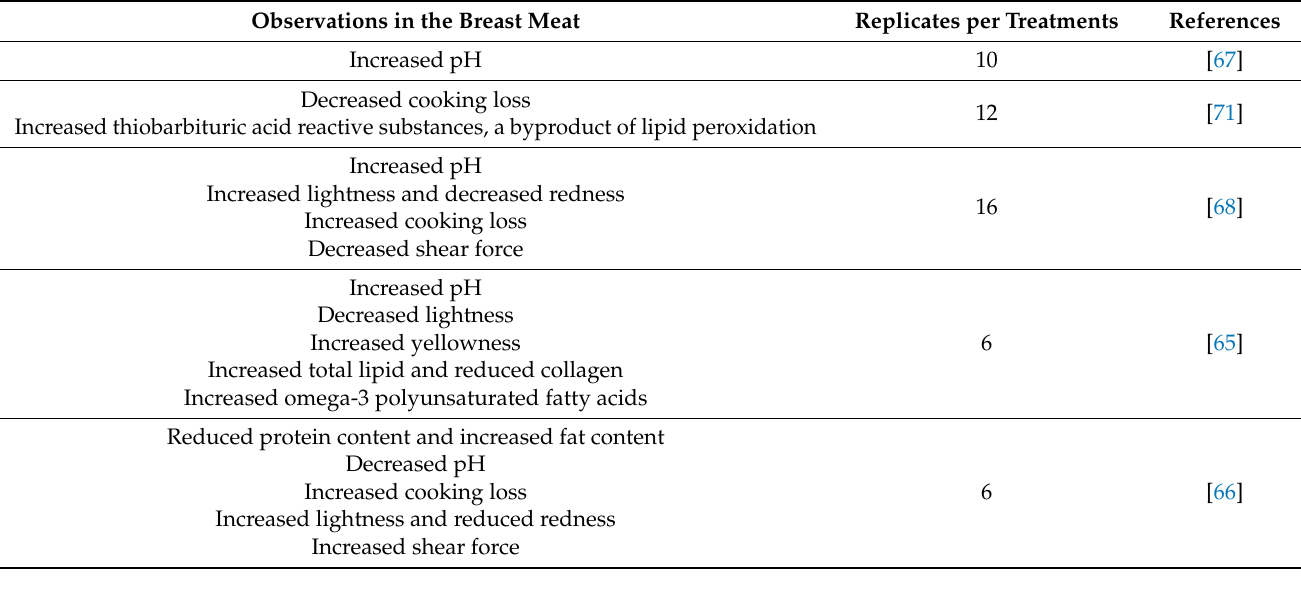
Table 3. Impact of heat stress on broiler meat quality.